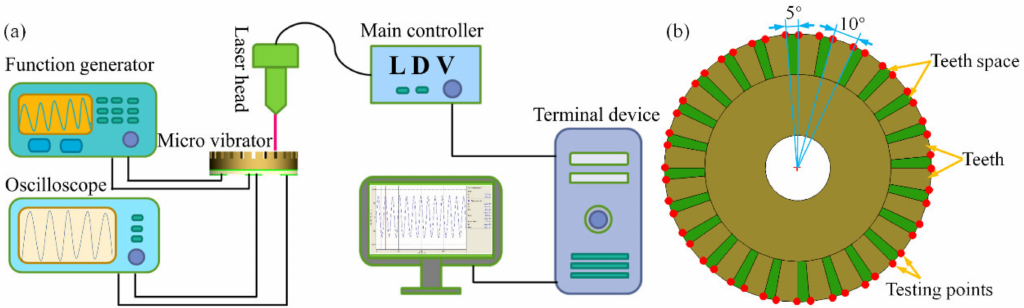
Figure 3. ( a ) Diagram of amplitude measuring experimental system; ( b ) Distribution of testing points on the teeth of the ring-type micro vibrator.